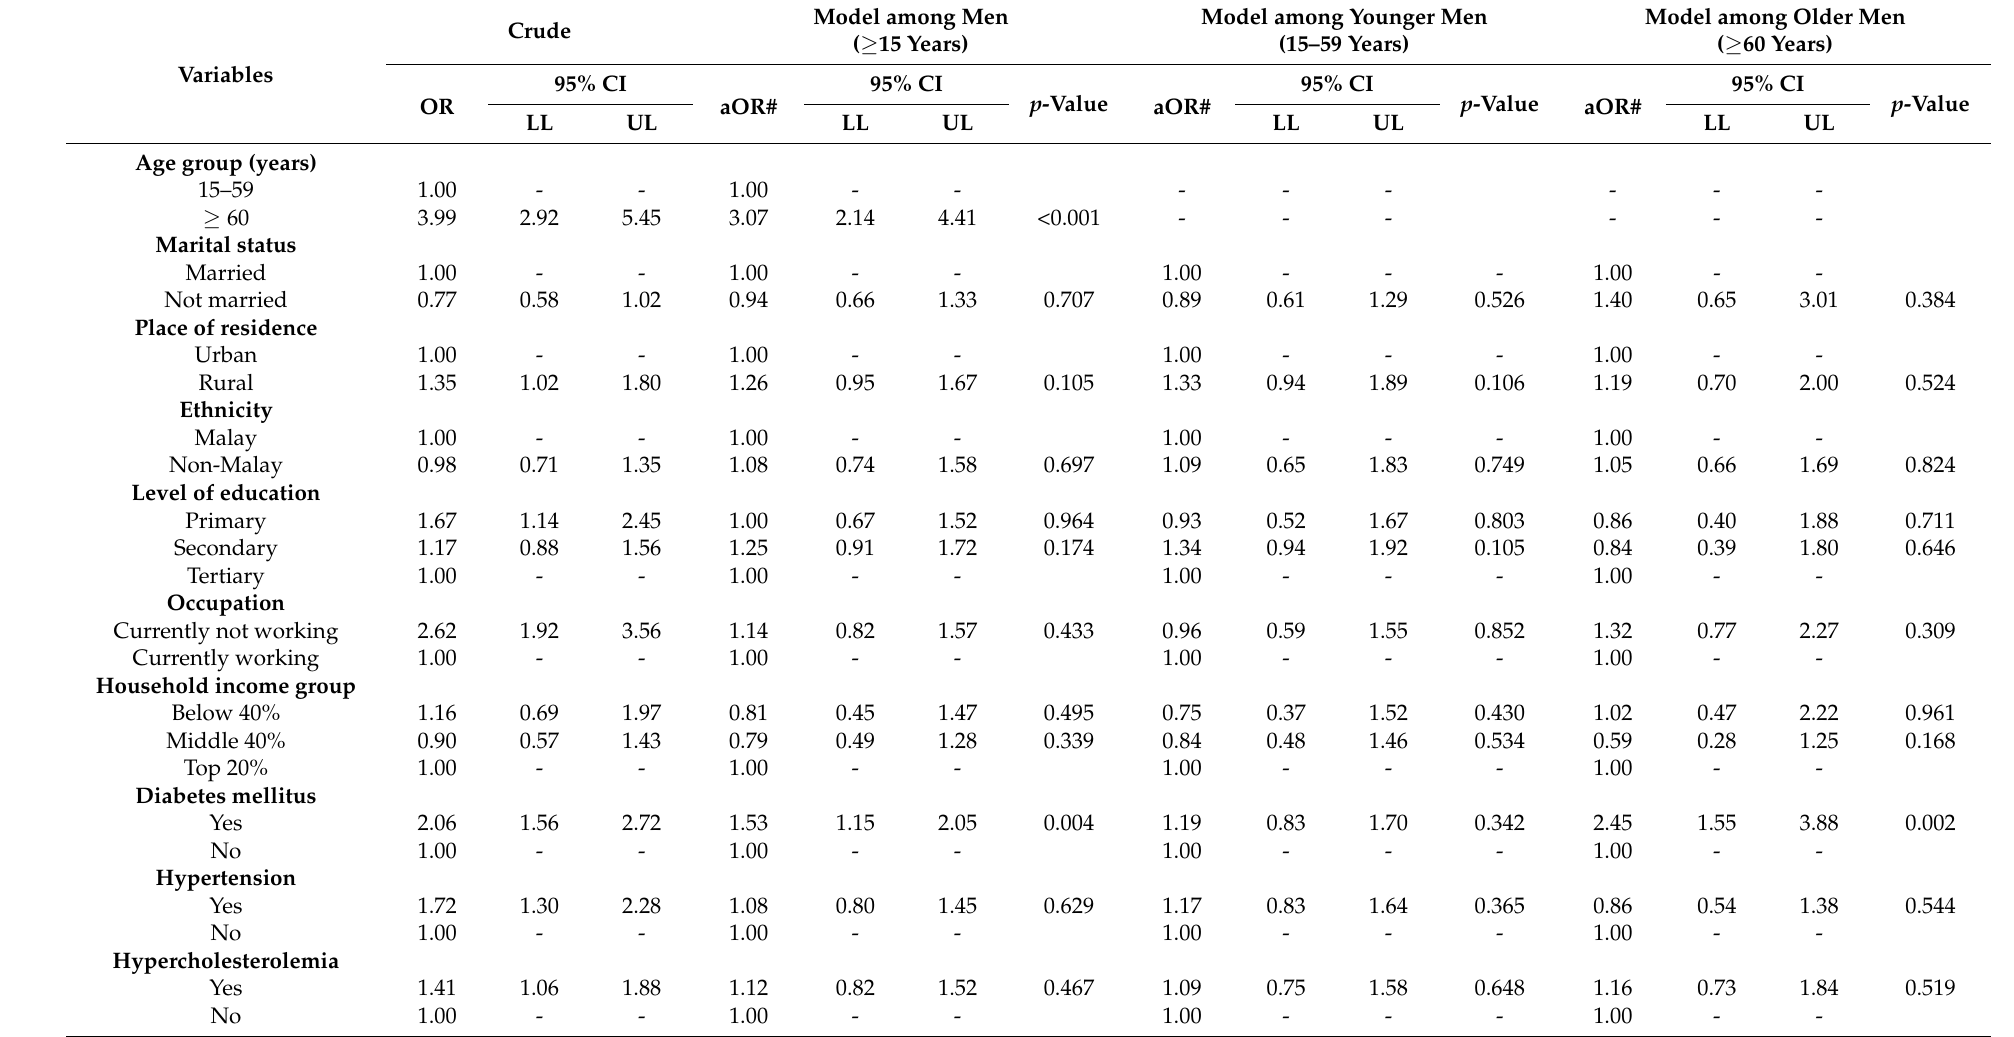
Table 2. Factors associated with anemia among all men, younger men and older men in